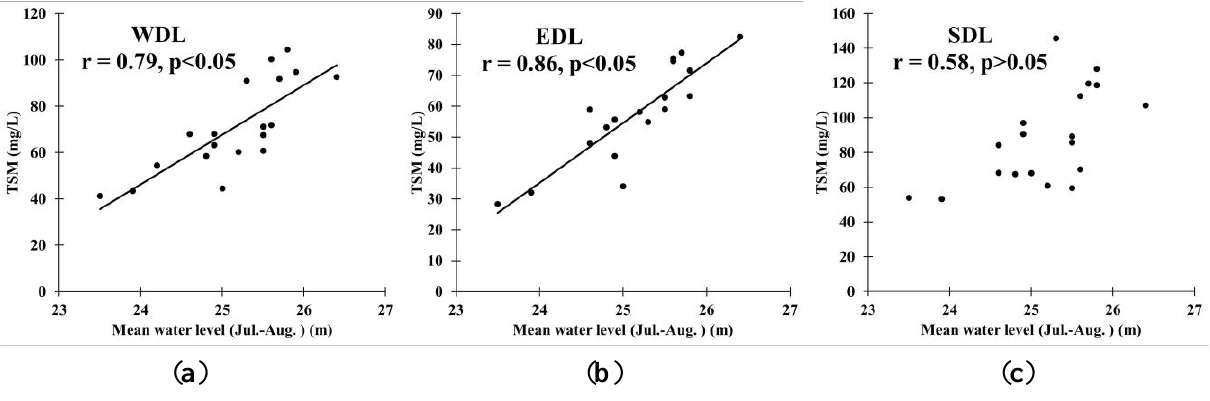
Figure 6. Relationship between mean TSM and mean water level from July to